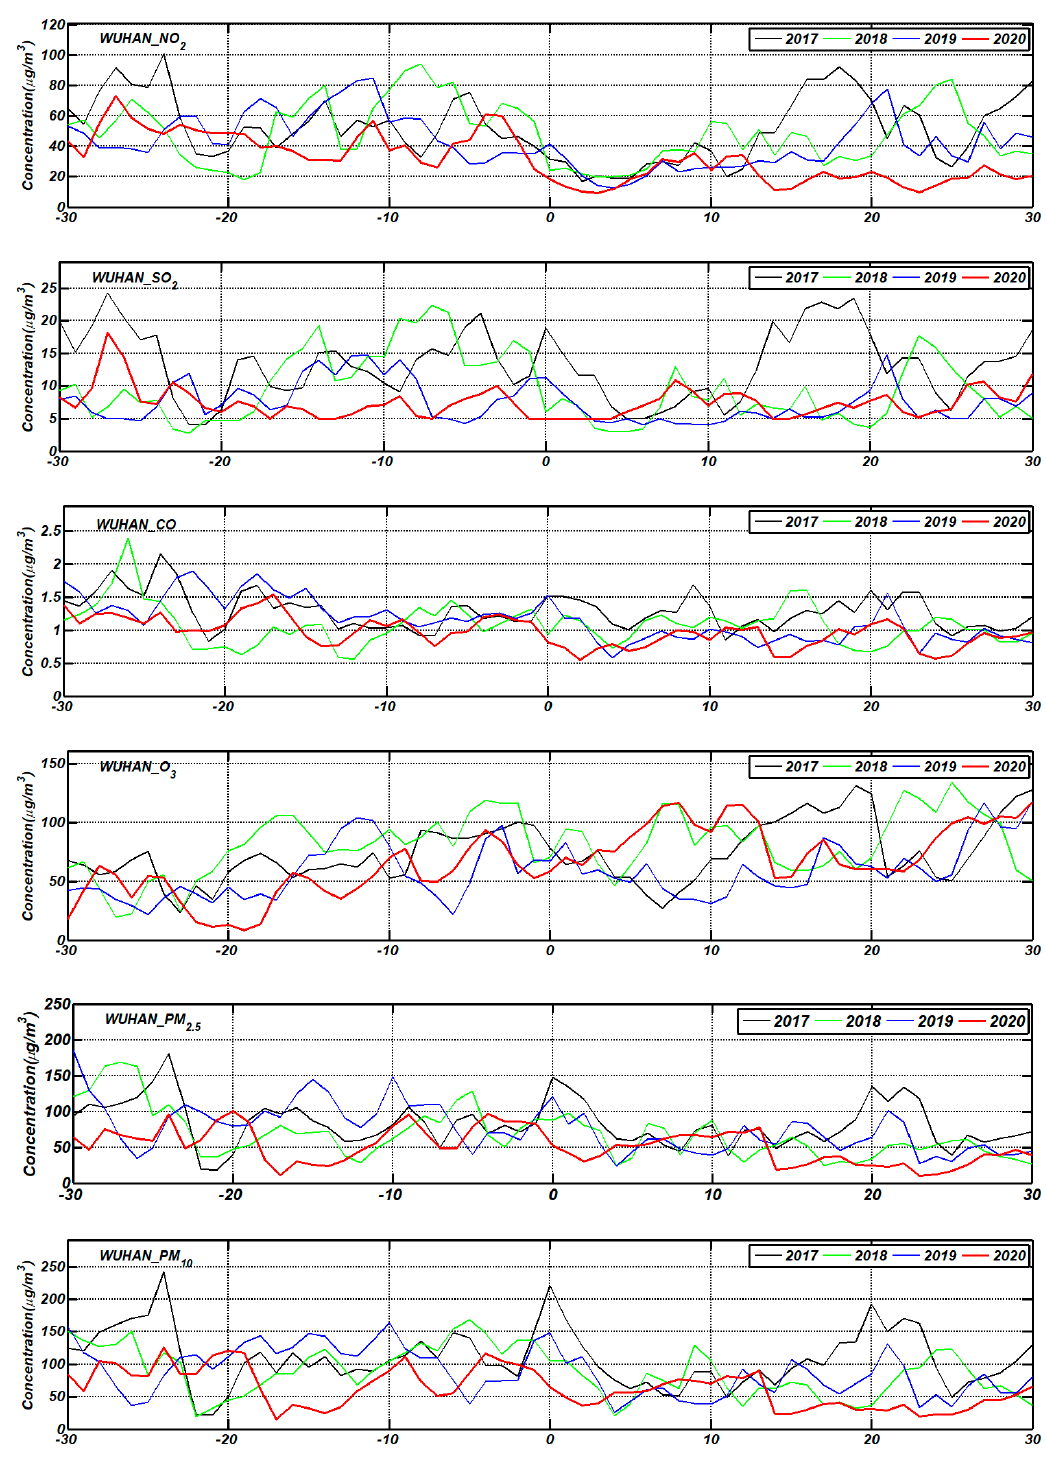
Figure 7. Time series of ground-based concentrations of NO 2 , SO 2 , PM 2.5 , PM 10 , CO, and O 3 measured in Wuhan during 2017–2020, from 30 days before to 30 days after the Spring